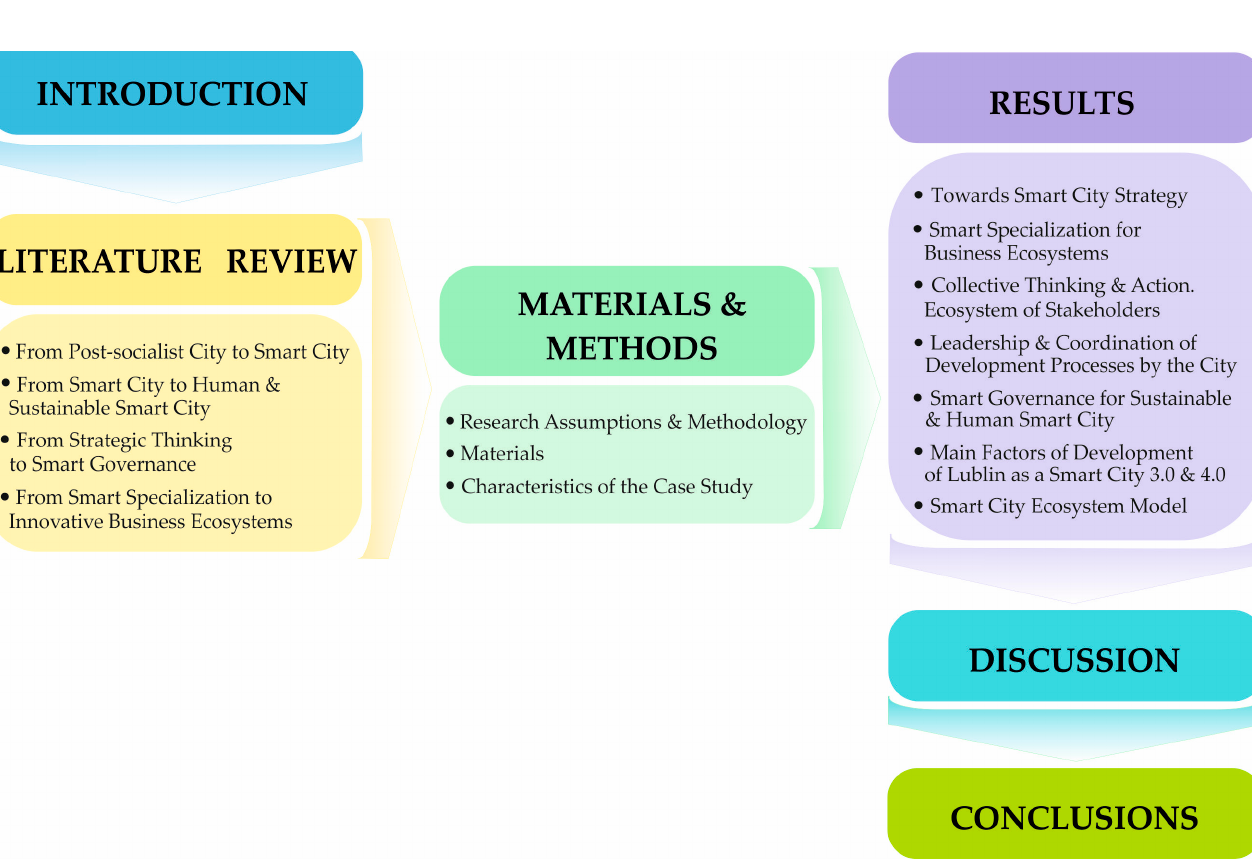
Figure 1. Flow of research.